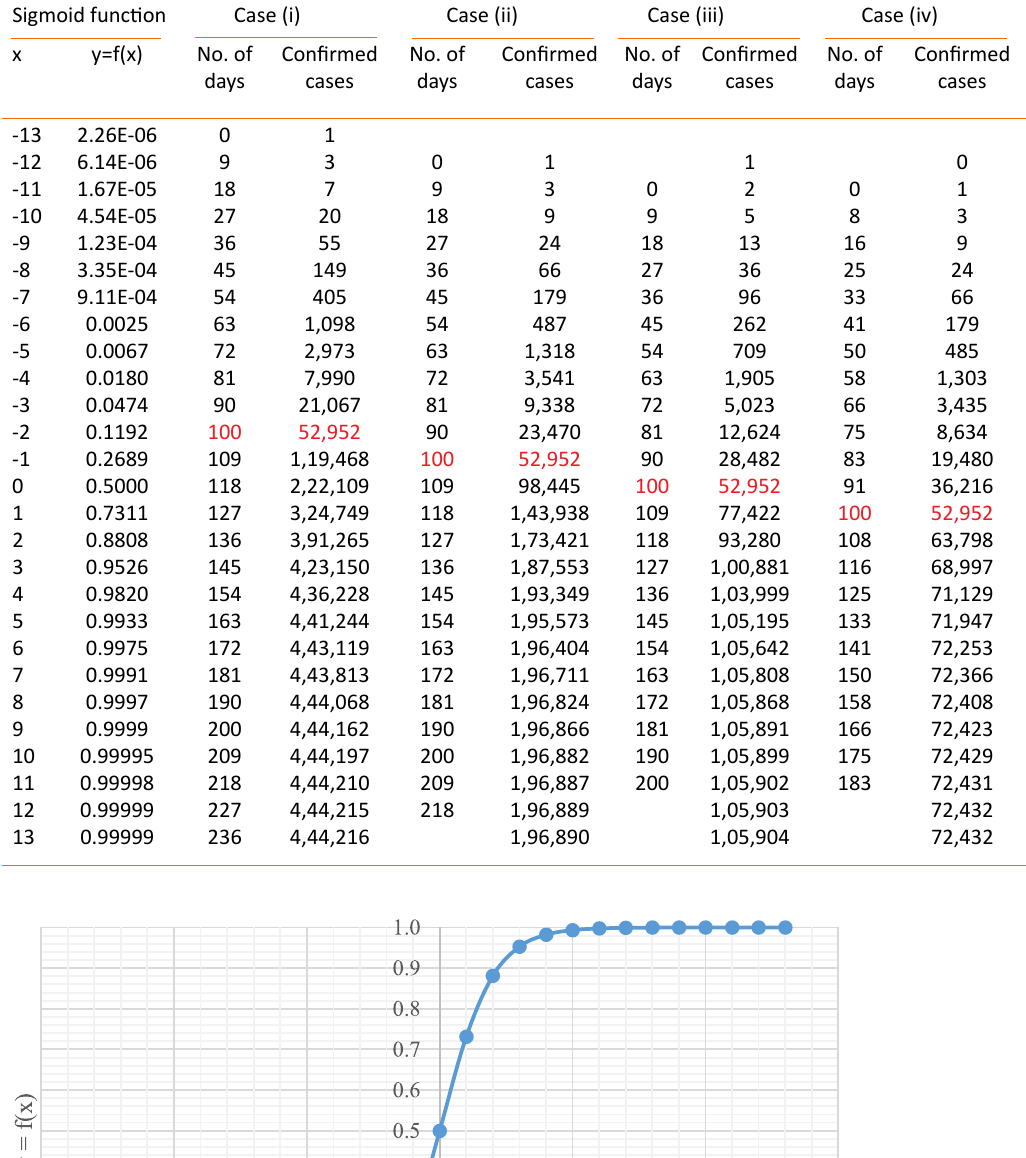
Table 2. Forecasted possibilities of confirmed cases in the future for India using S curve Sigmoid function